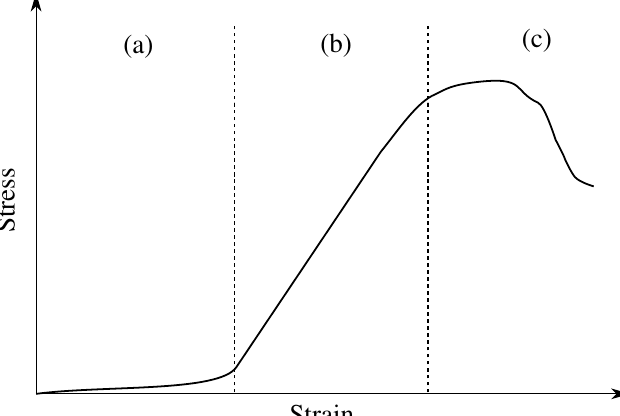
Figure 1. Stress–strain curve behavior of human tendons. Region ( a ) elastic behavior of the tendon where high deformation is presented under low stress. Region ( b ) linear behavior of tendon where deformation is proportional to applied stress. Region ( c ) tendon failure zone.